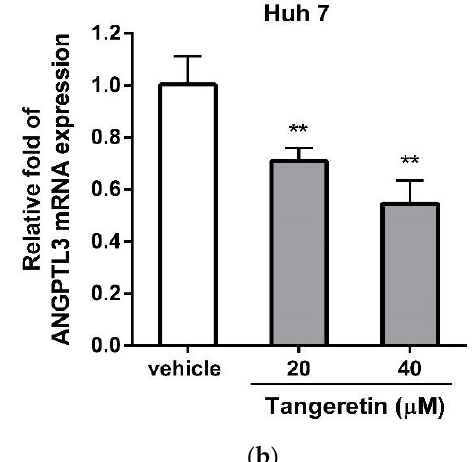
Table 1. The down-regulated genes associated with regulation of lipoprotein lipase activity in tan- geretin-treated cells.